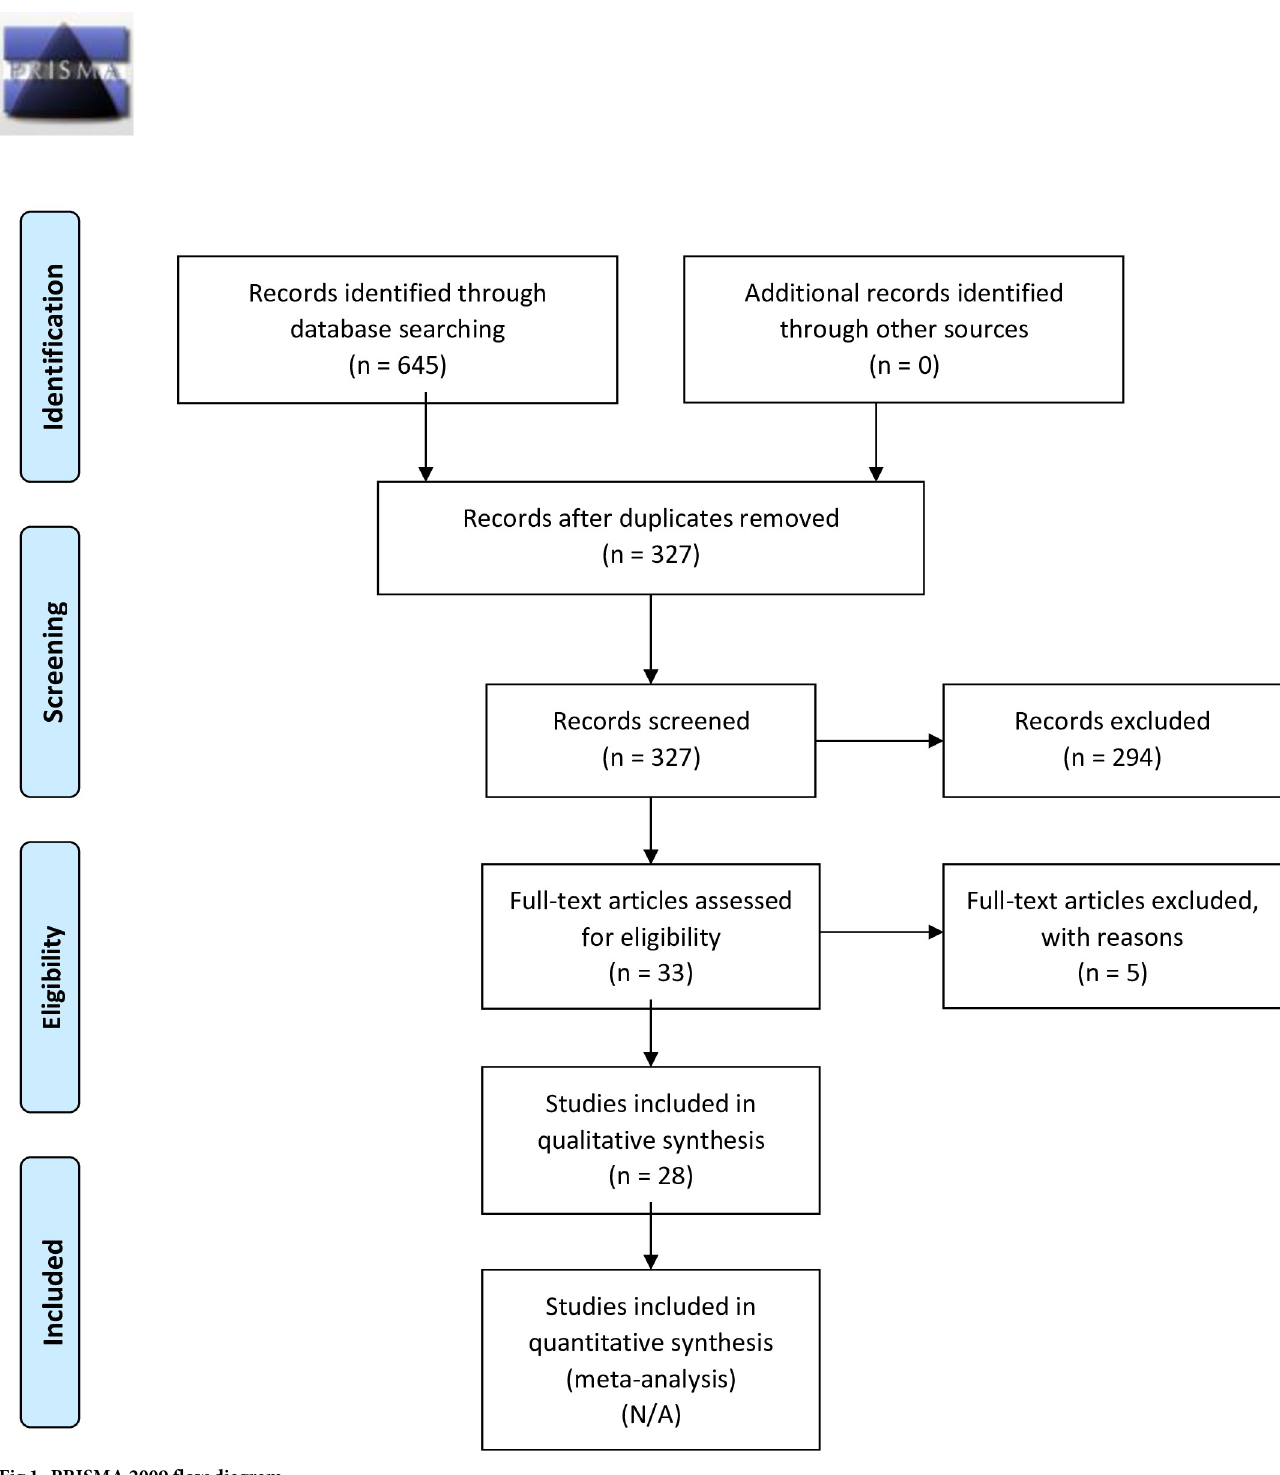
Fig 1. PRISMA 2009 flow diagram.